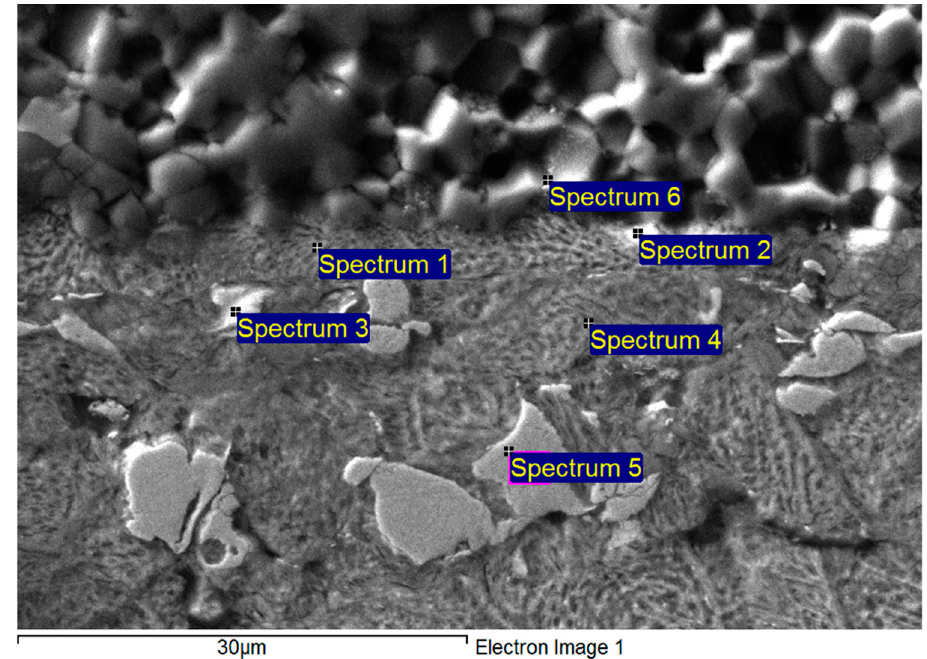
Figure 15. The EDX analysis of the AlN/Zn–Al–Mg joint boundary (marked AlN ceramics). Table 5. The phase composition results of AlN/Zn-Al-Mg joint boundary.